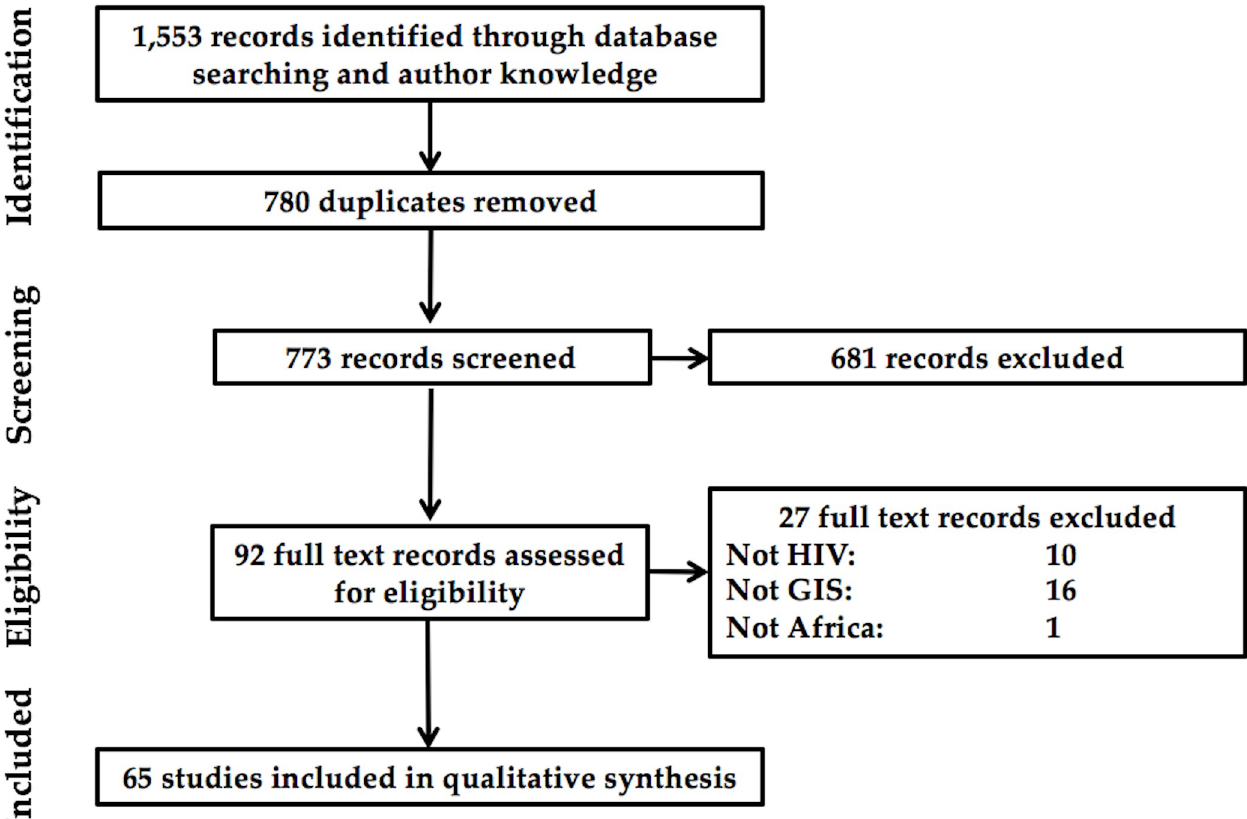
Fig 1. Flowchart of article selection.